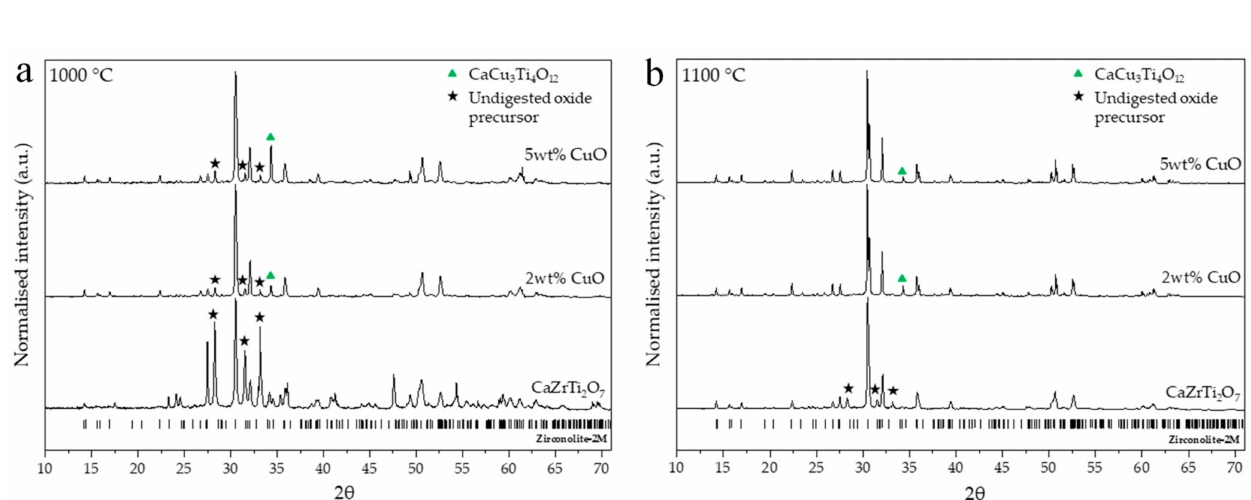
Figure 1. Powder X-ray diffraction data obtained for compositions synthesised at ( a ) 1000 ◦ C and ( b ) 1100 ◦ C. CaCu 3 Ti 4 O 12 characteristic reflections are highlighted with green triangles and precursor phase reflections are highlighted with black